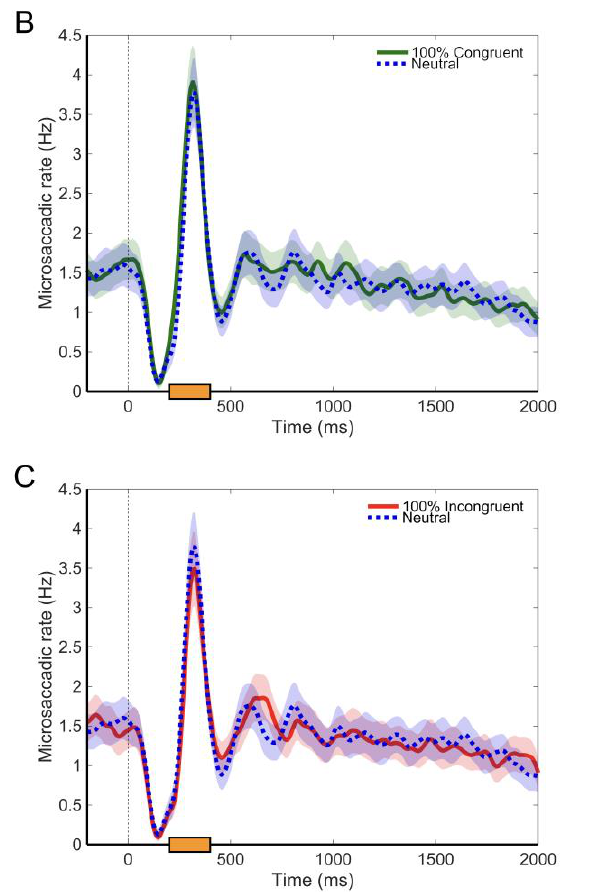
Figure 4 Mean microsaccadic rate, computed within a time window starting from cue onset (i.e., t = 0) and ending at the flanker stimulus onset (i.e., t = 2000). Shad- ed areas are SEM. Panel A depicts the 100% congruent vs. 100% incongruent comparison; Panel B depicts the 100% congruent vs. neutral comparison; Panel C depicts the 100% incongruent vs. neutral comparison. The orange rectangle indicates the 200-400 ms temporal window in which a difference between conditions